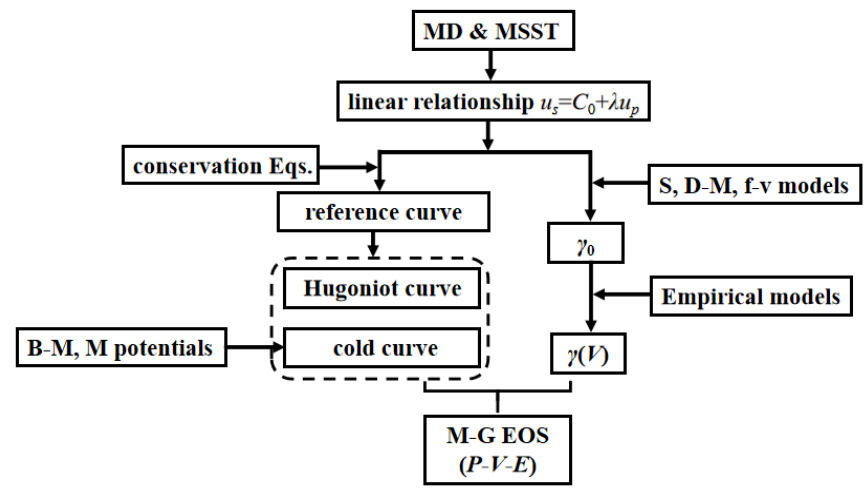
Figure 1. The flowchart of this Figure 1. T he flowchart of this work.